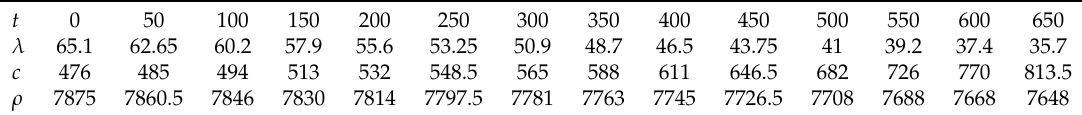
Table 1. Thermophysical properties of the